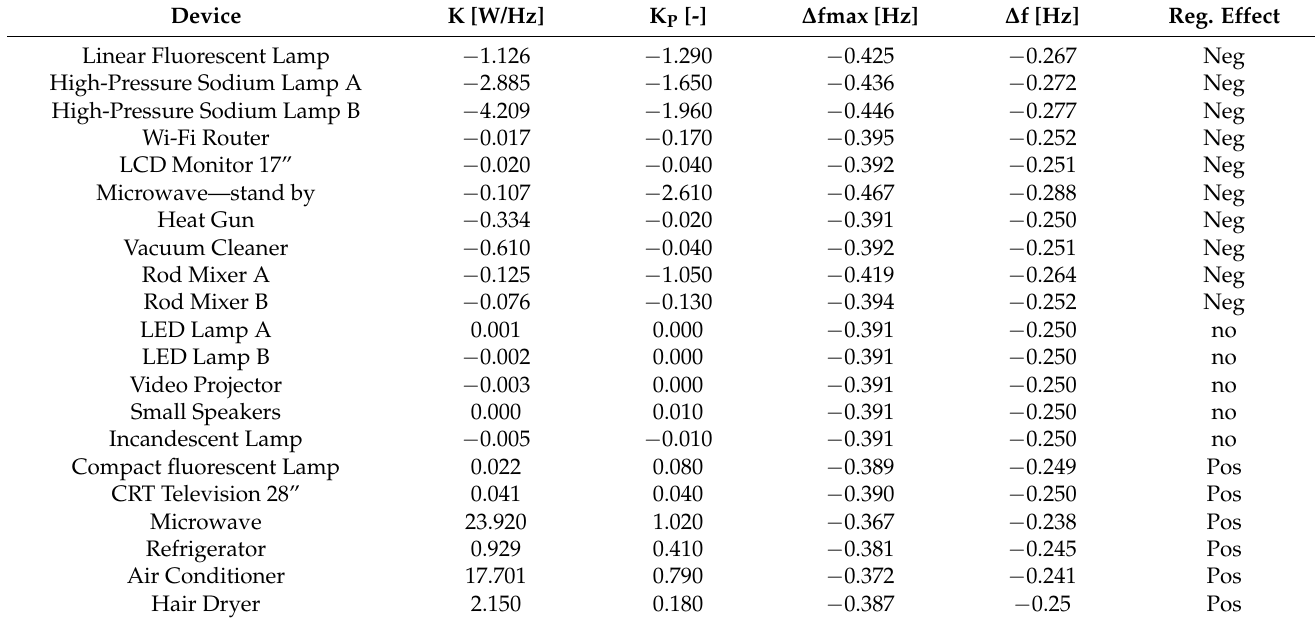
Table 9. Simulation results after production outage of 10% considering chosen appliances as only